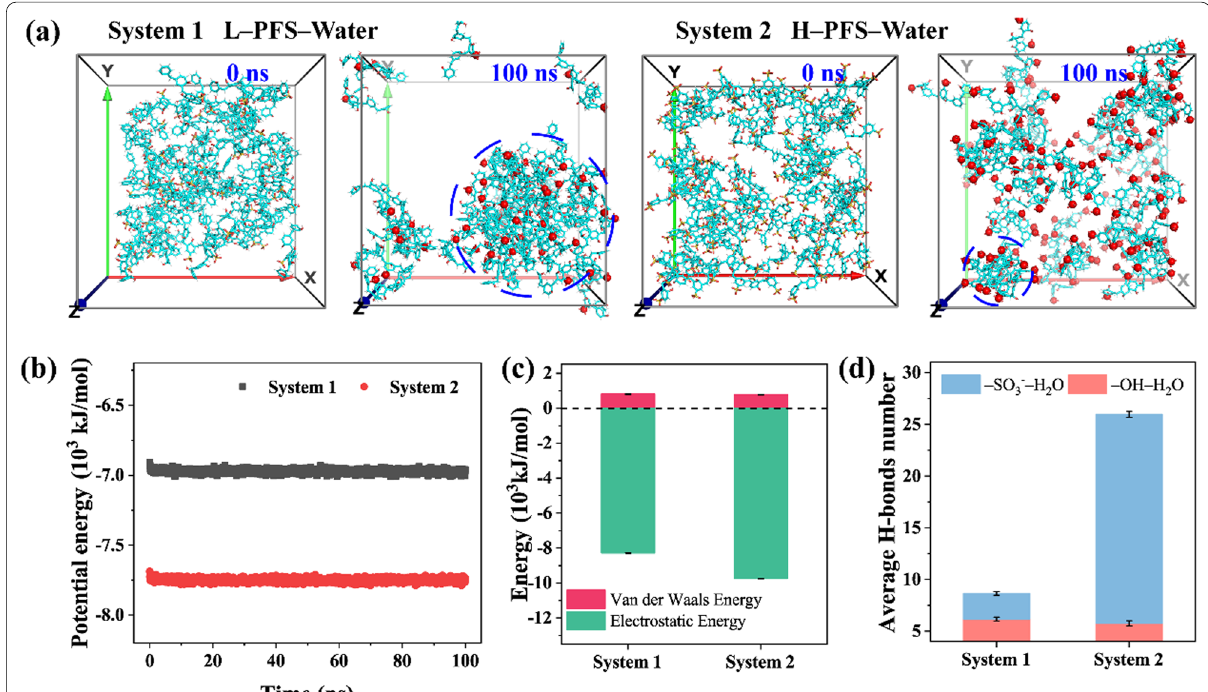
Fig. 4 a Snapshots of MD simulation systems 1 and 2 (water molecules are left off for better visual clarity, red ball represents sulfonic acid group); b potential energy; c electrostatic and van der Waals energies; d average number of hydrogen bonds formed by phenol hydroxyl and sulfonic acid groups of PFS and water from 50 to 100 ns